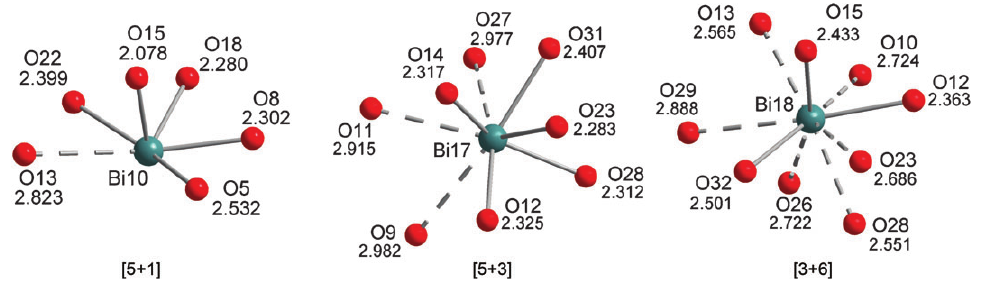
Figure 5 Selected bismuth coordination spheres in cluster 2 . The Bi - O bond lengths are given in Å . The coordination numbers of the bismuth atoms are shown in square brackets.